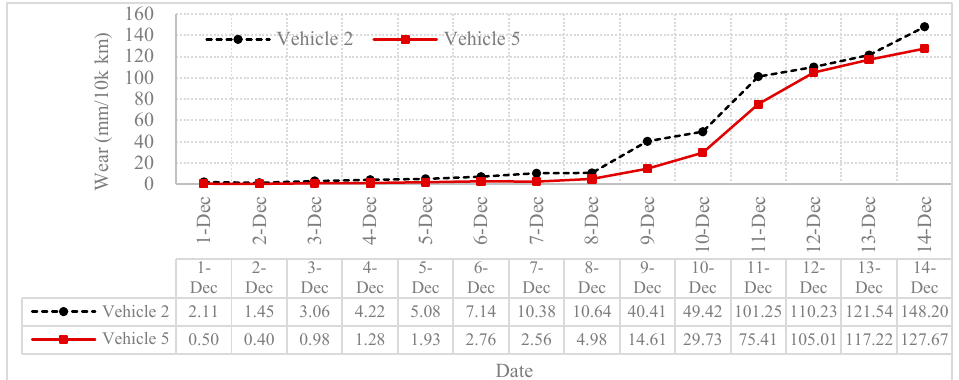
Figure 3. Pantograph strip average daily wear rate before and during irregular wear.